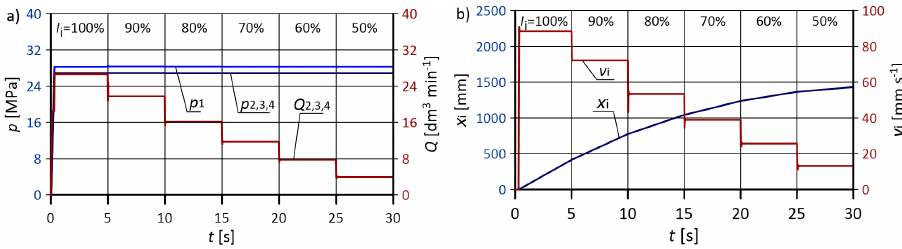
Figure 9. Results of the LSB system, equal load force F load , i = 135 kN; ( a ) pressures and flow rates, ( b ) speeds and positions of actuators.